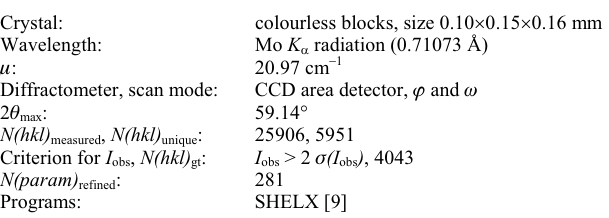
Table 1. Data collection and handling.